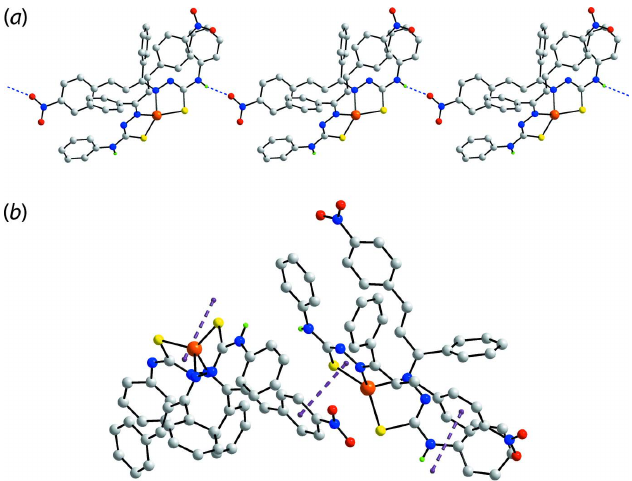
Figure 2 Molecular packing in (I): ( a ) a view of the linear supramolecular chain featuring amine-N—H (cid:3)(cid:3)(cid:3) O(methoxy) hydrogen bonding shown as blue dashed lines and ( b ) detail of the (cid:2) (phenyl)– (cid:2) (chelate ring) interaction shown as purple dashed lines. In each image, non-participating H atoms are